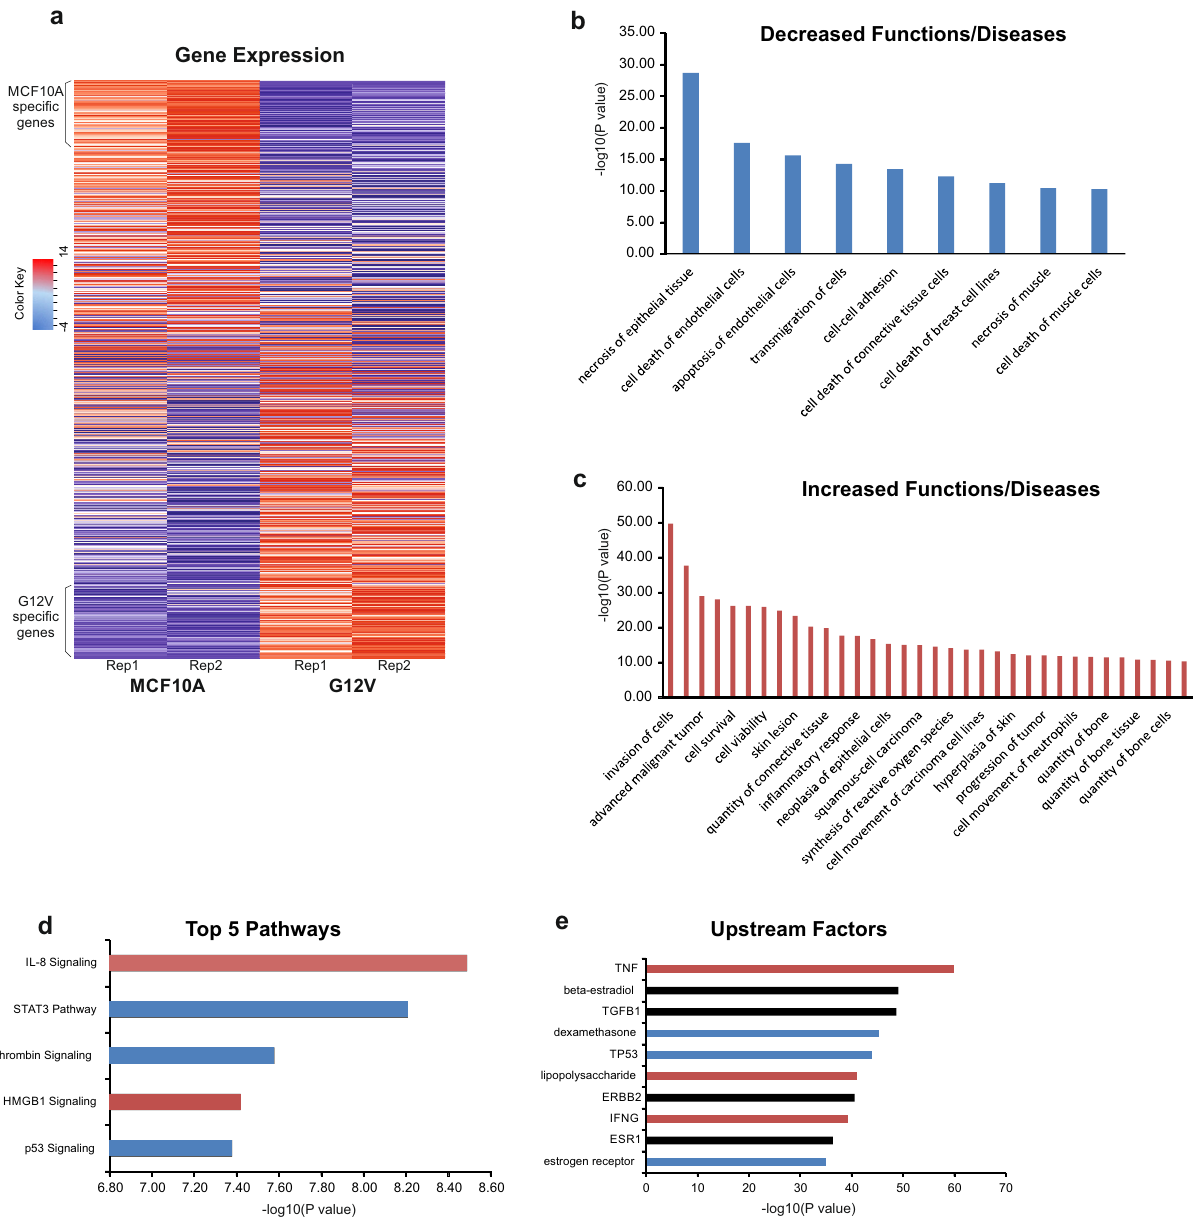
Fig. 2 Transcriptional reprogramming induced by the G12V HRas oncogene. a Heatmap showing gene expression of genes in MCF10A and G12V cells from two replicas. Rows were fi rst ordered based on log2 fold change and then by expression value. b, c Functions and Diseases enriched in down- regulated genes ( b ) and up-regulated genes ( c ) with a log10 pVal >10. d Top fi ve signi fi cantly affected pathways according to the DE genes. e Top 10 upstream factors which can explain the changes in gene expression. Red - Predicted activation; Blue- Predicted inhibition; Black- No speci fi c direction of activity. Analysis in b – e was done using the Ingenuity Pathway Analysis